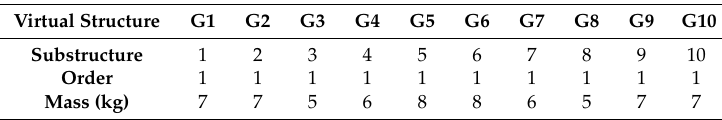
Table 4. Ten groups of virtual